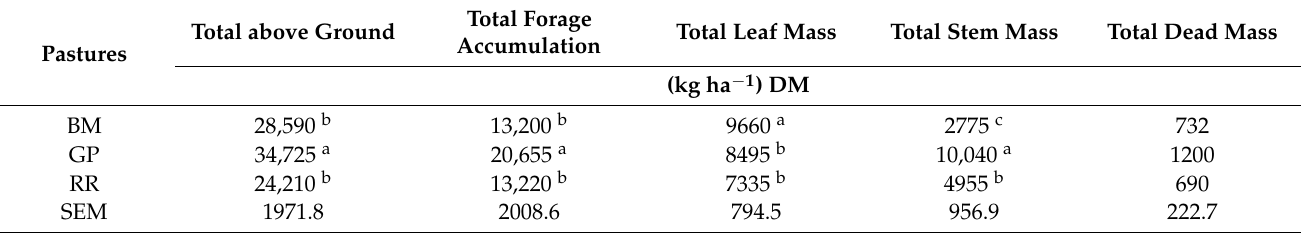
Table 3. Effect of pasture species on total forage mass, forage accumulation and plant part com- position (kg ha − 1 ) DM measured in five harvests at Gatton Research Dairy, Queensland, Australia from November 2020 to May 2021. Brachiaria Mulato II (BM), Gatton panic (GP), Rhodes